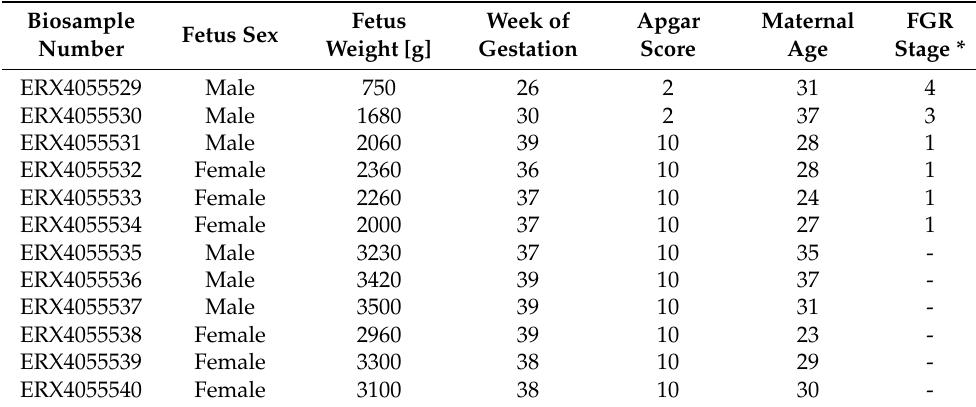
Table 1. Characteristics of the placental